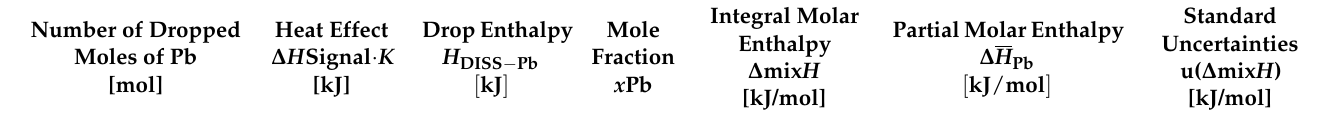
Table 3. The integral mixing enthalpy of (Ag 0.25 Mg 0.75 ) 1 − x Pb x . Standard states: pure liquid